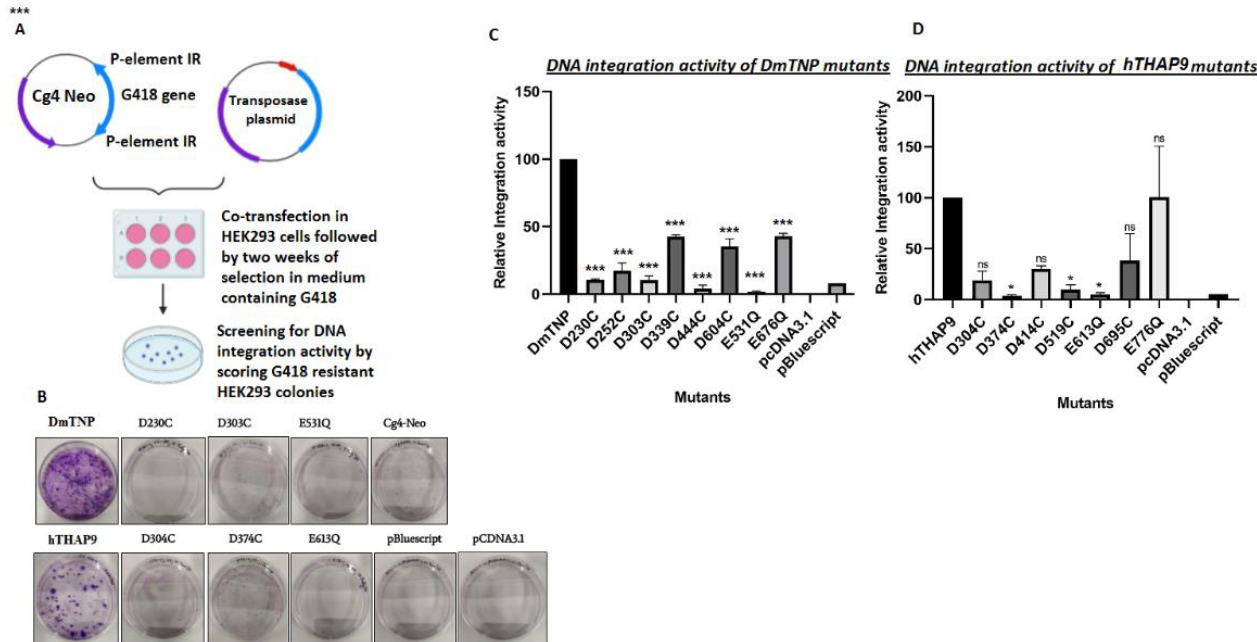
Figure 6. Conserved acidic residues within the catalytic triad and signature string of DmTNP and hTHAP9 are important for DNA integration. ( A ) Schematic of the transposon integration assay. ( B ) Crystal violet-stained G418-resistant colonies of wildtype Drosophila and hTHAP9 along with DDE motif mutants and negative controls. Relative integration activities of ( C ) DmTNP mutants (compared to wild type DmTNP) and ( D ) hTHAP9 mutants (compared to wild type hTHAP9). Empty vectors pCDNA3.1 (+) and pBluescript were used as negative controls. All the values are represented as the mean of two independent experiments performed in duplicates ( ± SEM). p -value < 0.05, *** ( p <0.001), * ( p <0.033), ns ( p < 0.12).